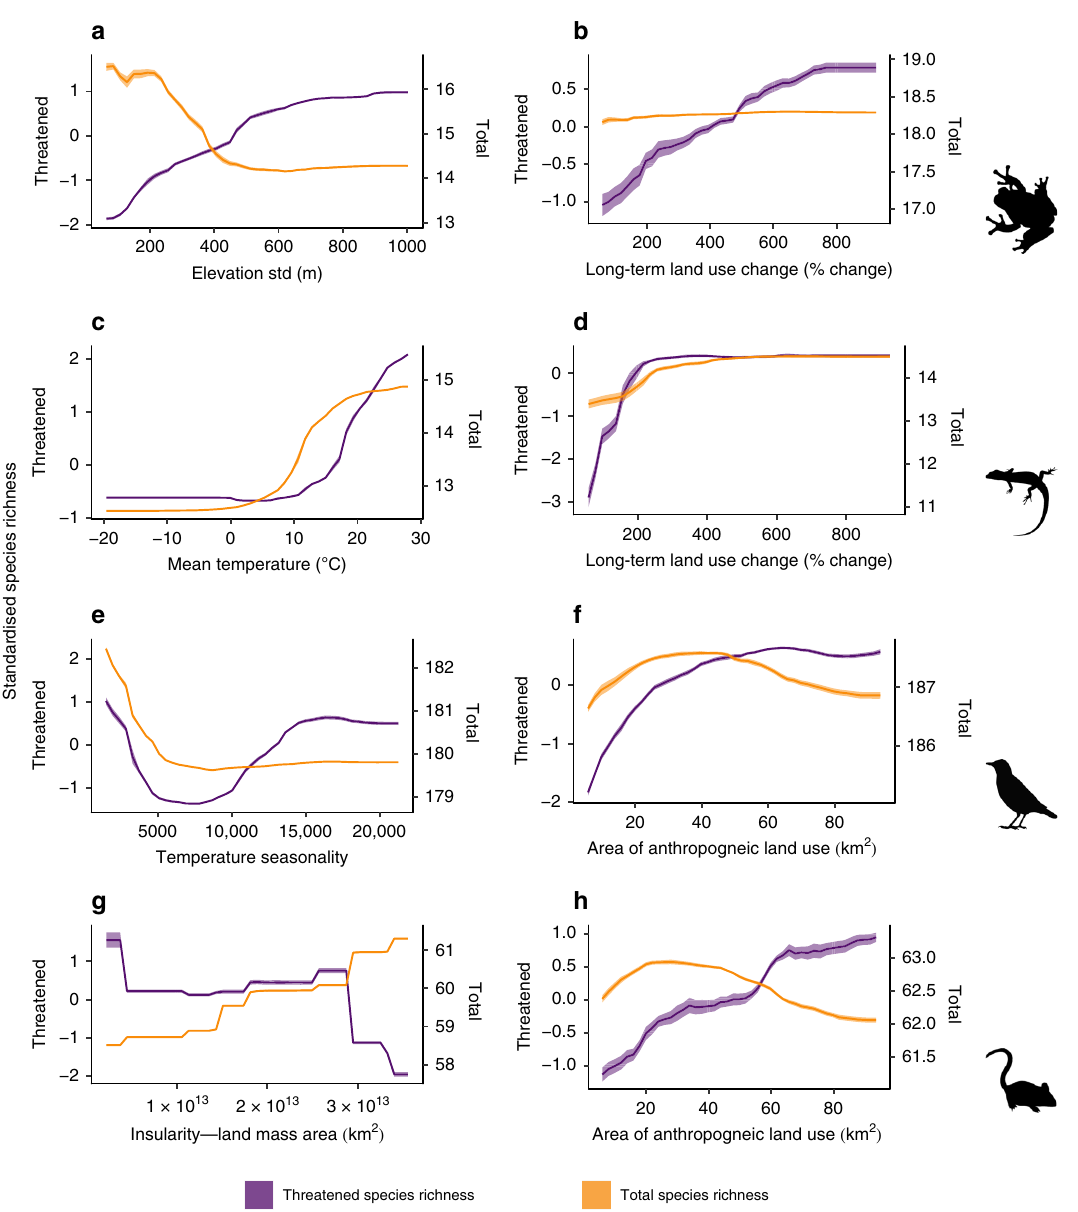
Fig. 4 Relationships between a selection of the most important environmental and human impact covariates and global amphibian, reptile, bird, and mammal species richness. Lines indicate the mean partial relationships between variables and threatened (purple) and total (orange) species richness from across 10 random forest models for amphibians ( a , b ), reptiles ( c , d ), birds ( e , f ) and mammals ( g , h ). Shaded areas indicate the standard deviation around the mean partial relationships. The x-axis is limited to the central 90% of a variable ’ s range. Note the separate y-axes for threatened and total species richness. Plots of all variable relationships can be found in the Supplementary Figs. 10 and 11. Source data are provided as a Source Data fi